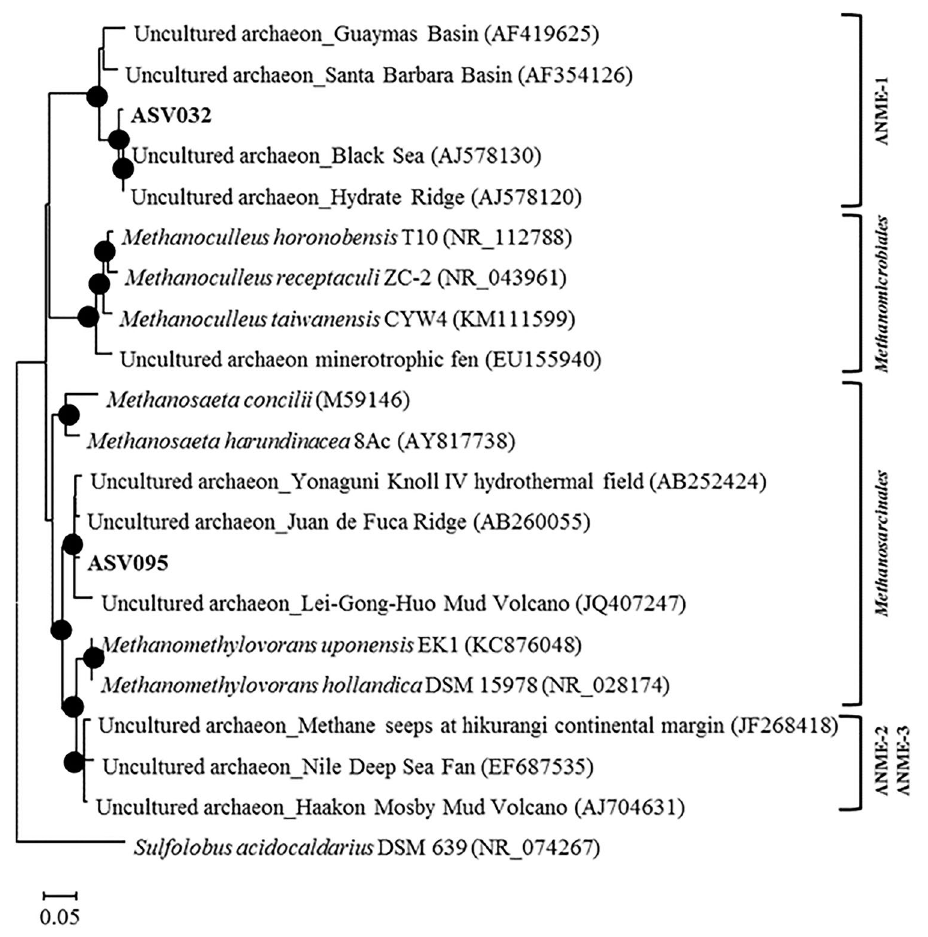
Figure 7. Phylogenetic tree of archaeal rDNA sequences obtained from authigenic